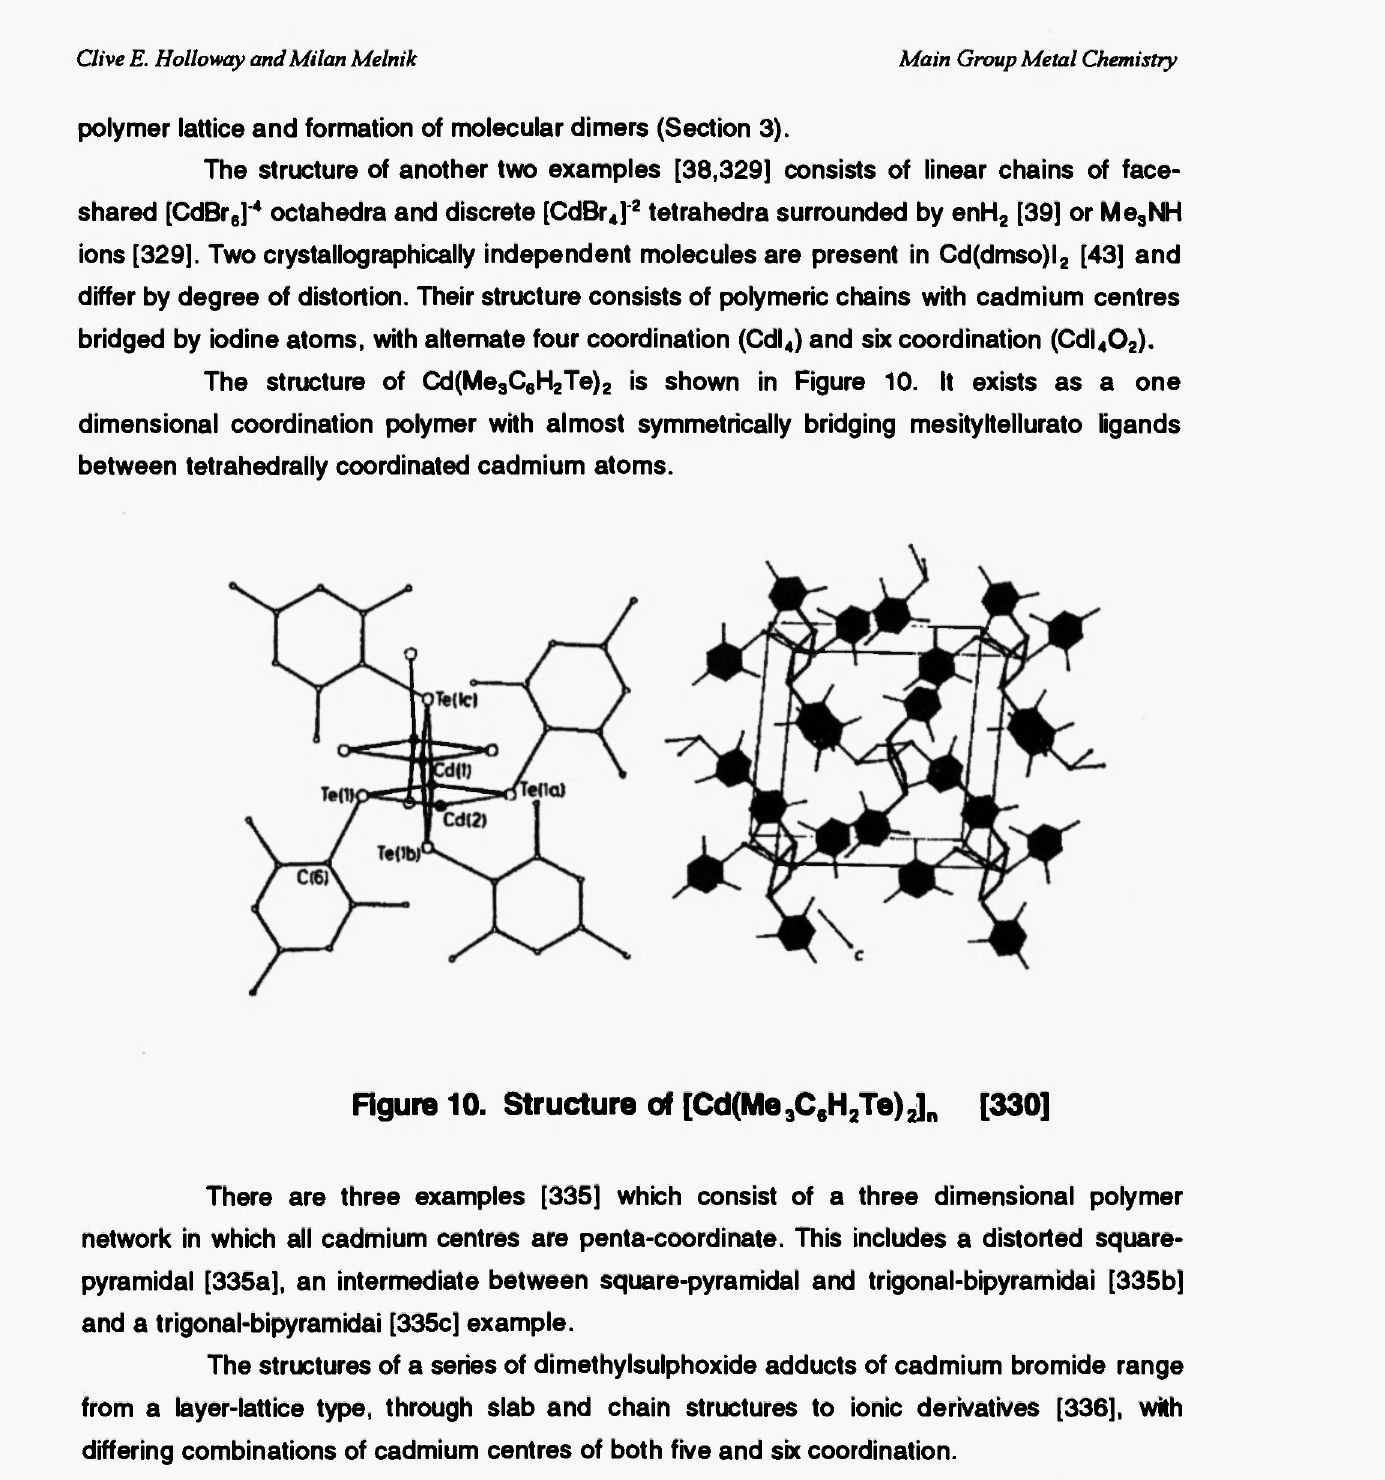
Figure 10. Structure of [Cd(Me